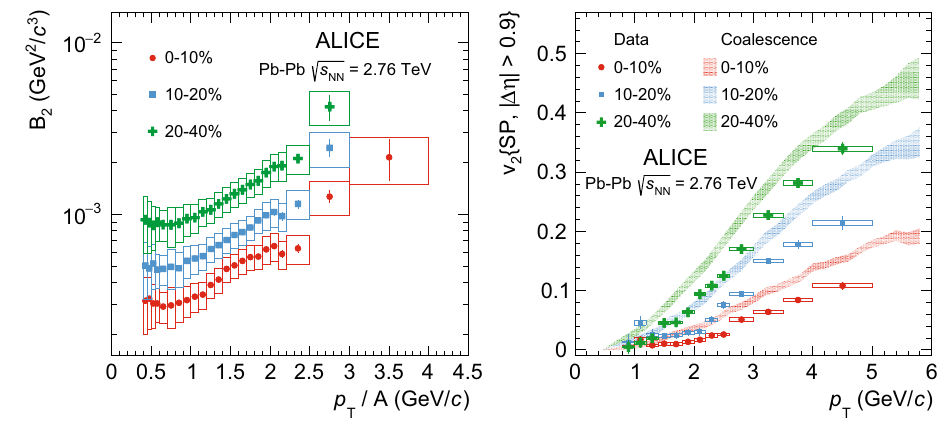
Fig. 8 Left: Coalescence parameter B 2 as a function of the transverse momentum per nucleon ( p T /A) for different centrality classes. Right: Measured v 2 of d+d compared with the expectations from simple coalescence (Eq. 13) for different centrality intervals as indicated in the legend